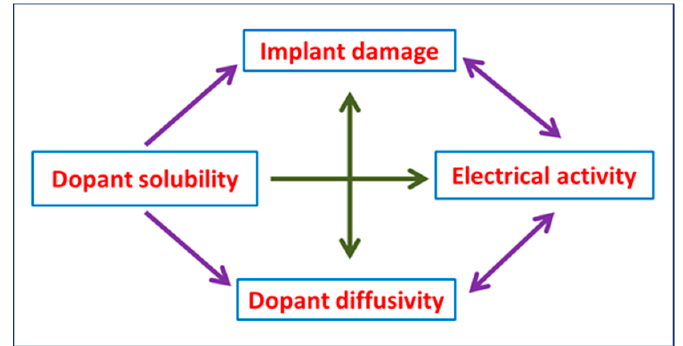
Figure 8. Schematic of the implantation–diffusion interaction model during nitrogen ion implantation and post annealing treatment in diamond.